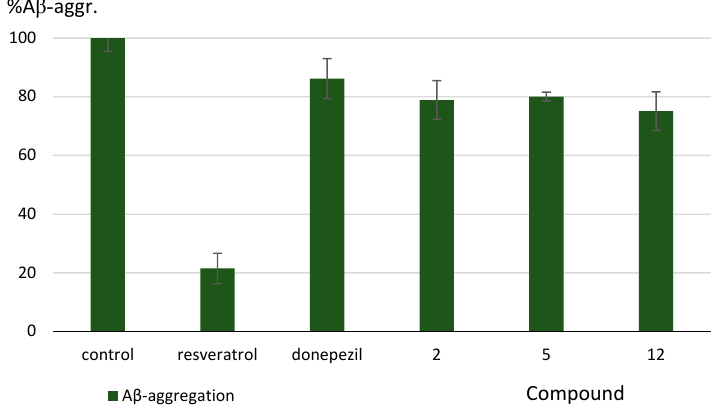
Figure 2. Effect of the synthesized compounds on A β aggregation. Values are expressed as means ± standard deviation (SD) for at least two independent experiments